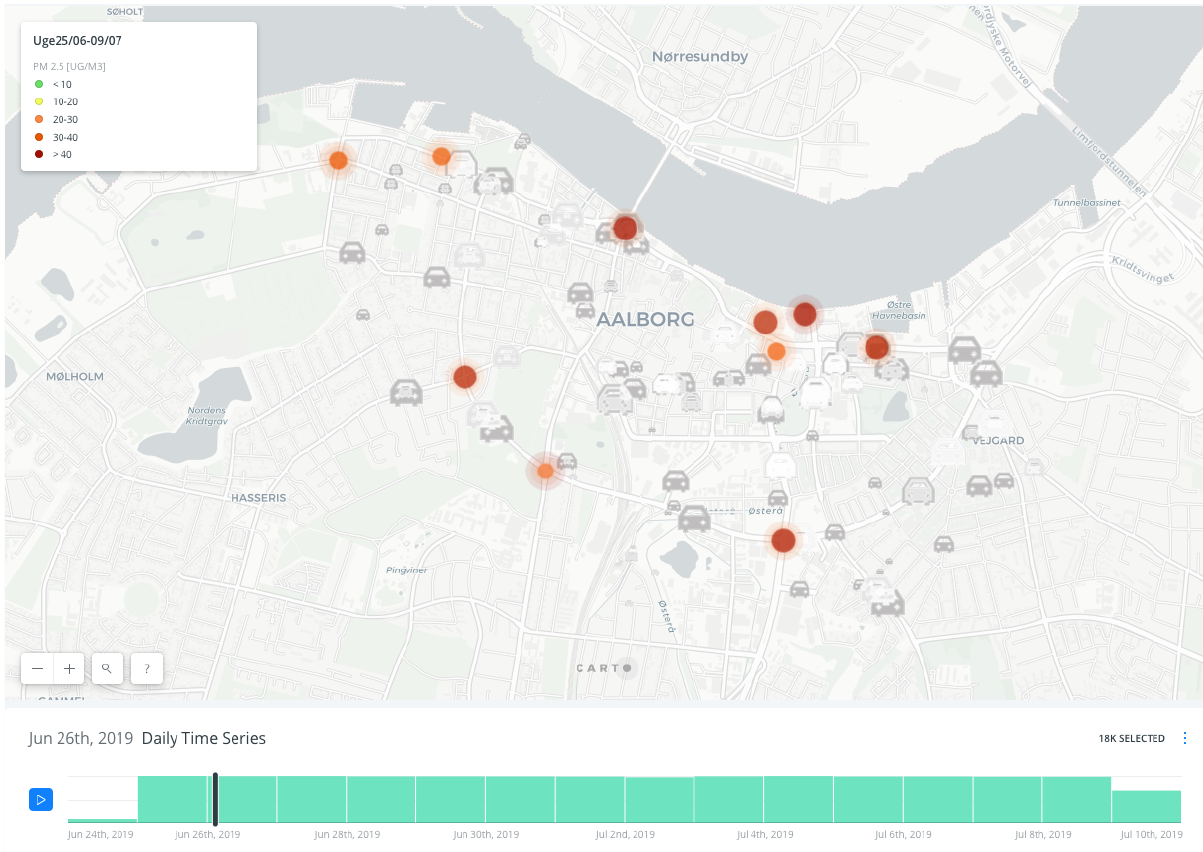
Figure 7. Time series programmed in CARTO with data from 10 CityProbes shown together with traffic data from recent traffic counts in Aalborg city. The animated version: https://dimoreno1992.carto.com/builder/6d9c7f90-fa52-4fe3-8e0d-6a0b9fdfc2f3/embed [online] accessed